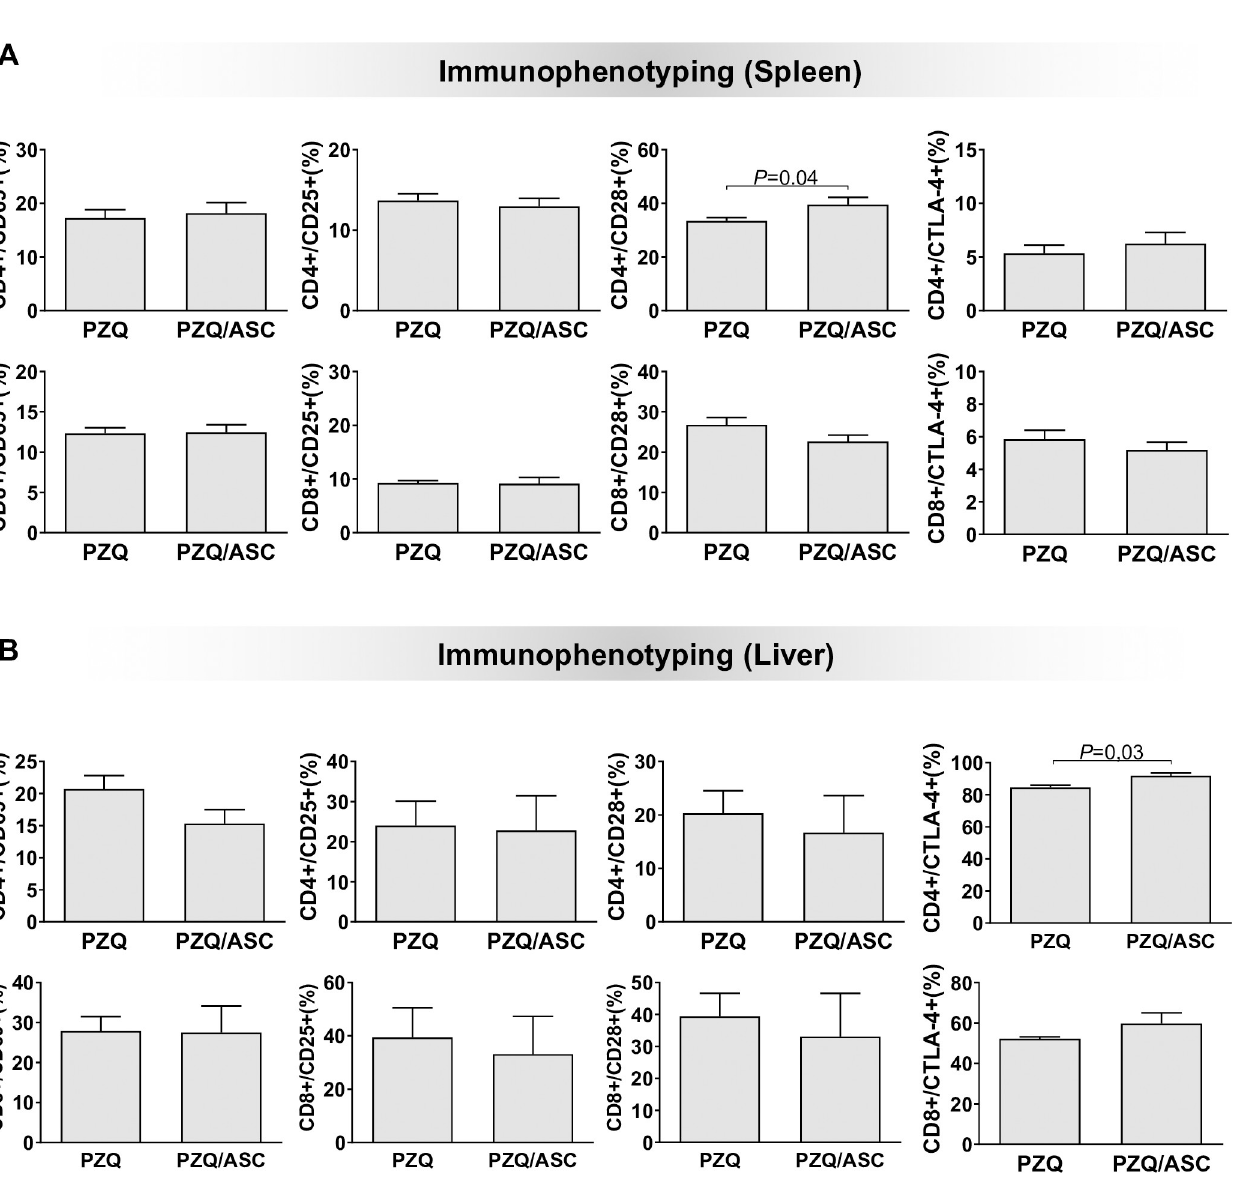
Fig 4. T cell activation before and after ASC therapy. Frequency of CD4 + and CD8 + T lymphocytes expressing CD69, CD25, CD28 and CTLA-4 in spleen (A) and liver (B) cells. The data are shown as means ± standard deviation. Horizontal lines indicate statistically significant differences (p < 0.05). PZQ = Praziquantel-treated group; PZQ/ASC = Praziquantel plus adipose tissue-derived stem cells-treated